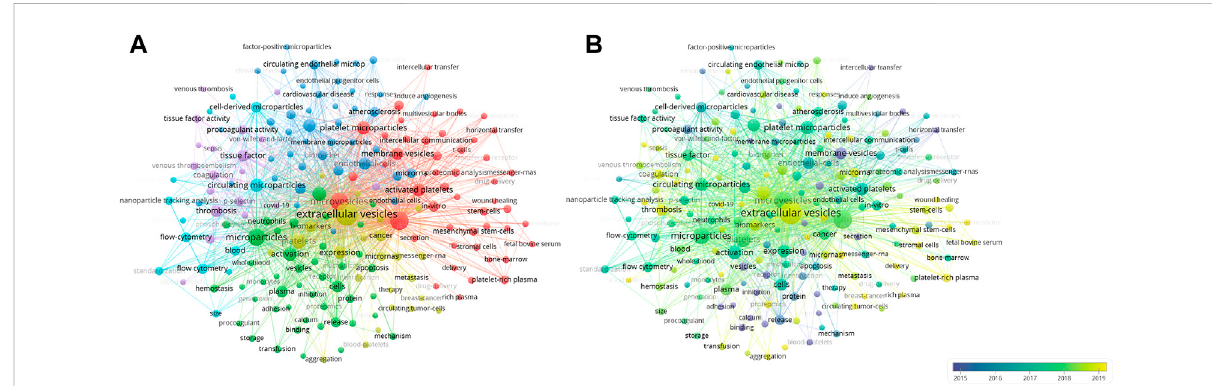
FIGURE 4 Keyword analysis. (A) Network visualization map showing cluster analysis of keywords associated with platelets extracellular vesicles. Different colors represent different clusters, green for “ vesicle secretion mechanism ” cluster, red for “ biological function ” cluster, blue for “ methods and omics ” cluster, purple for “ pathophysiology ” cluster, and yellow for “ clinical diseases ” cluster. (B) Network visualization map showing evolution of keyword frequency over time. Colors were assigned according to the average year in which keywords appeared in